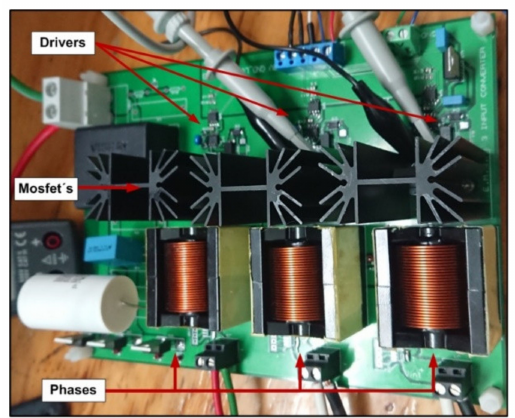
Figure 9. Implemented 1 kW prototype.